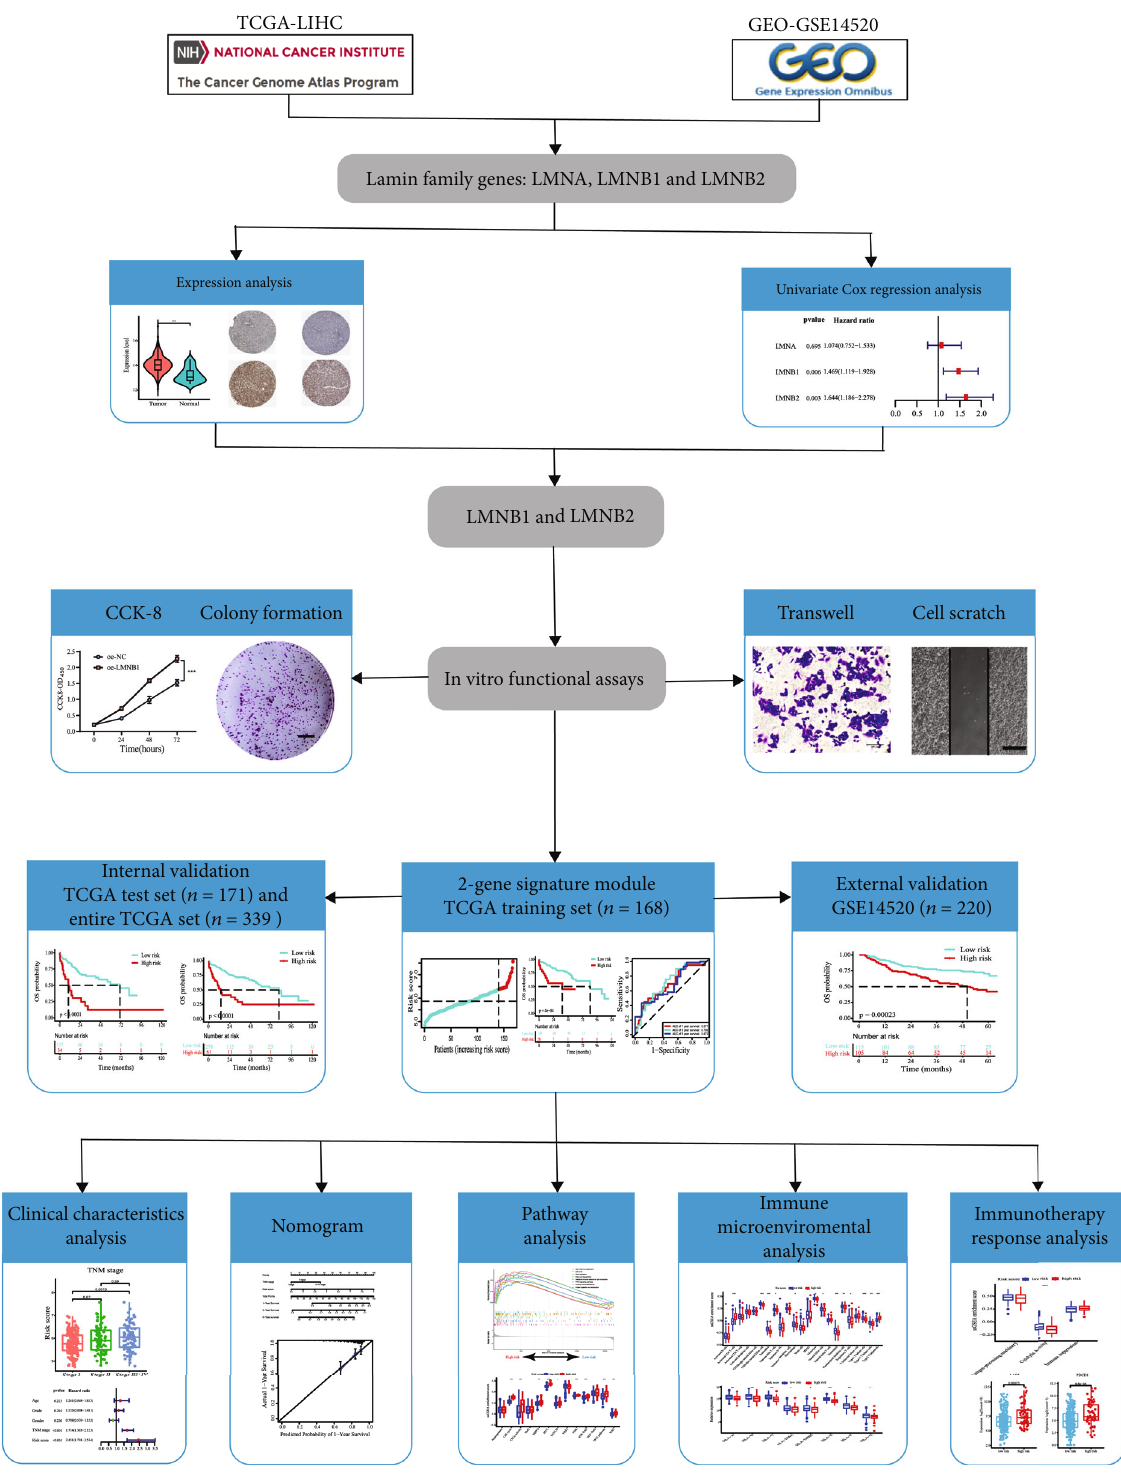
Figure 1: Flow chart of this